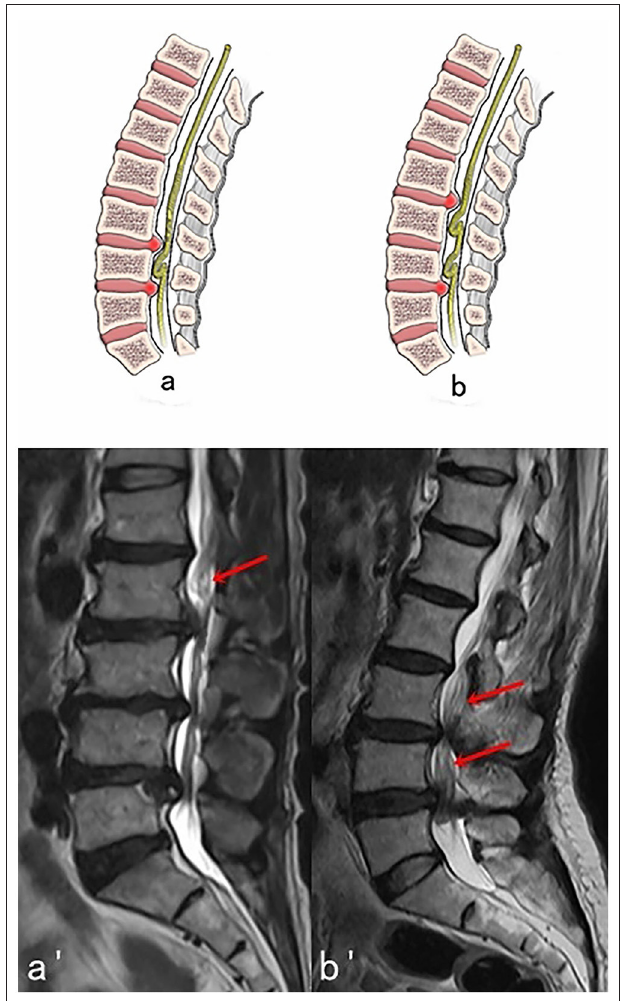
FIGURE 3 | Two possible subtypes of Intermediate RNRs (RNRs which are between the stenosis) with corresponding MRI images. (A,A ′ ) One segment of RNRs (red arrow) are between the stenosis. (B,B ′ ) Two segments of RNRs (red arrows) are between the stenosis.